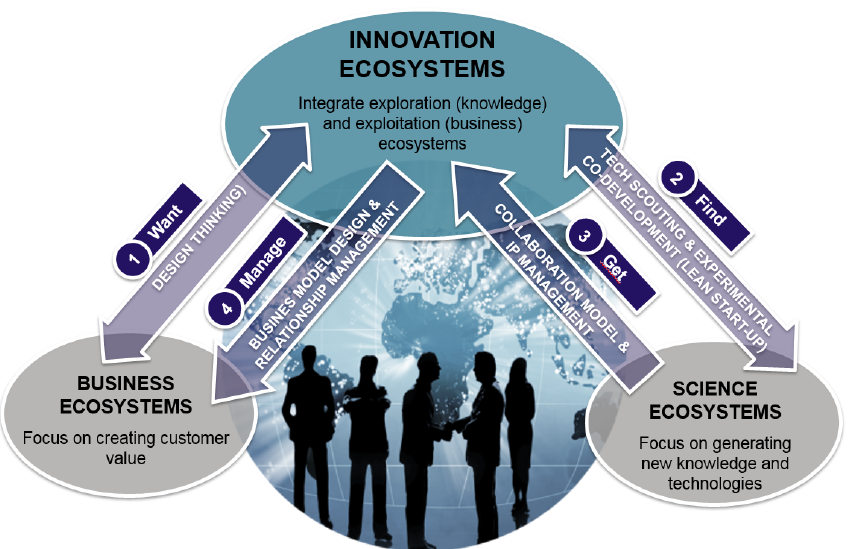
Fig. 1. The Logics of Innovation